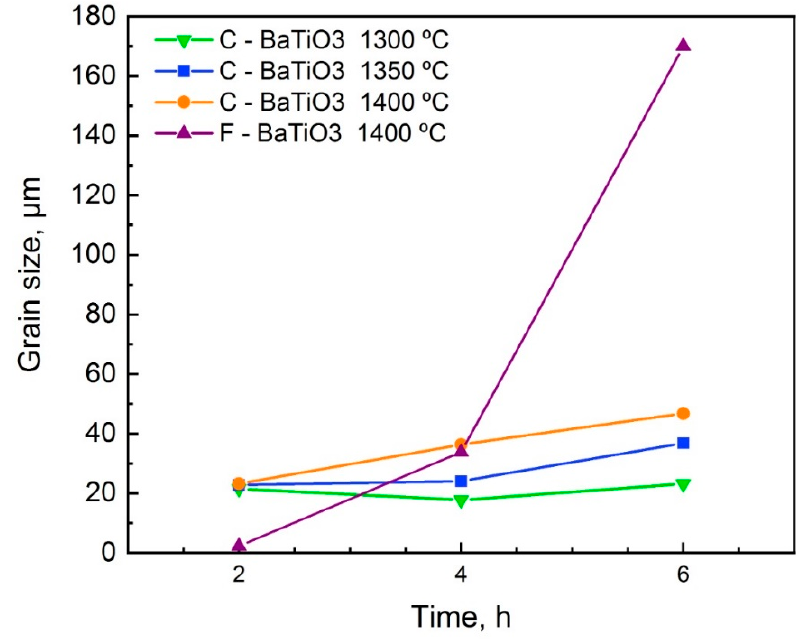
Figure 9. Grain size of BaTiO 3 samples dependence on temperature and dwell time of sintering.